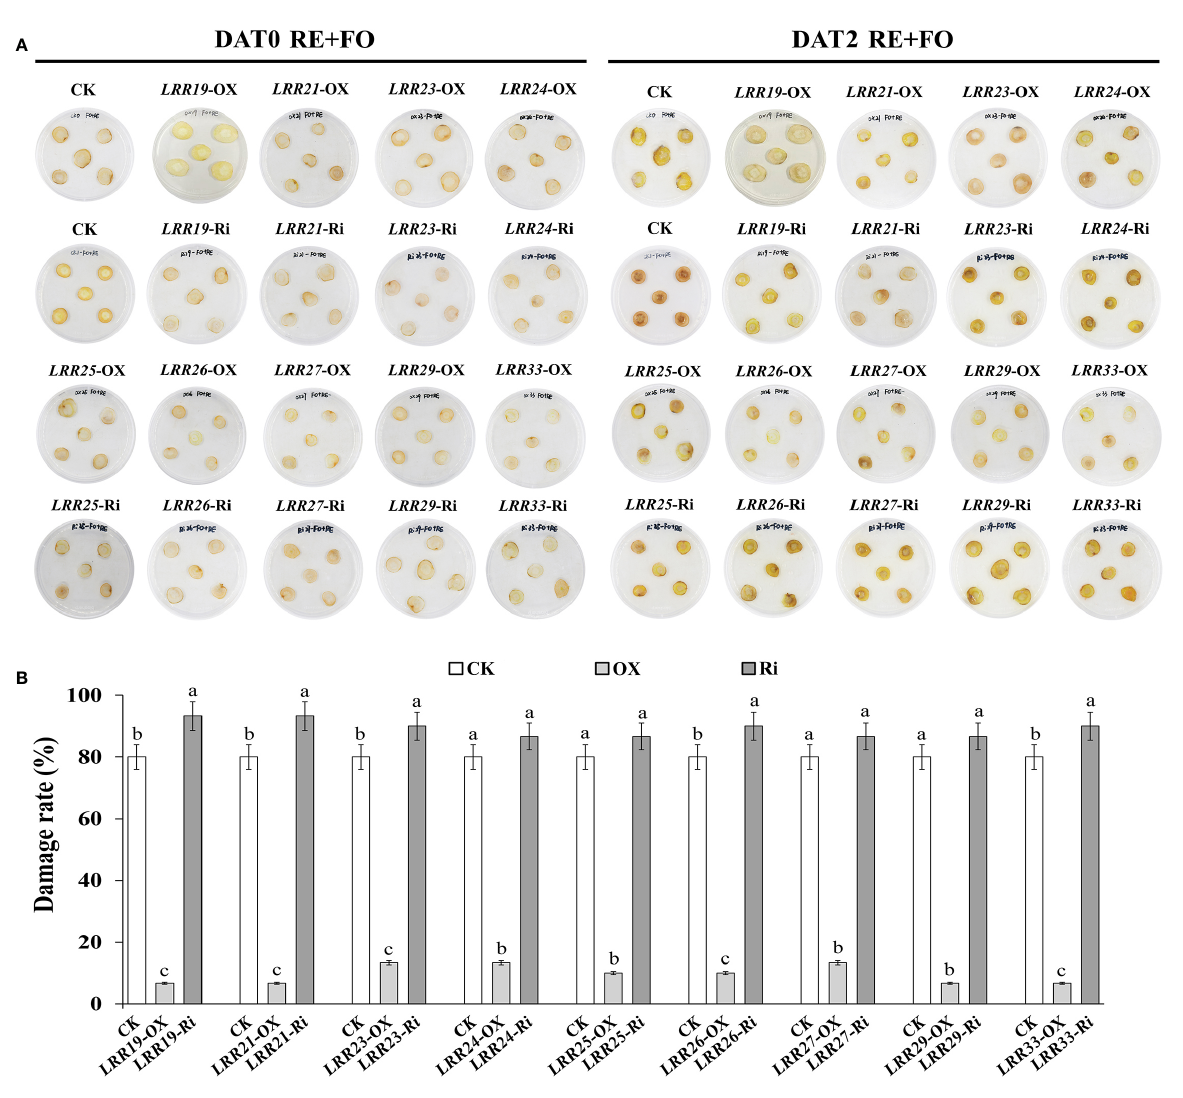
FIGURE 5 Phenotypic changes (A) and damage rate (B) of root segments with transient overexpression and interference of different RgLRRs under the treatment of comprehensive stress of root exudates and F. oxysporum . OX, Overexpression; Ri, RNA interference; CK, Empty vector as control; DAT, Days after treatment; RE+FO, the comprehensive treatment of root exudates and F. oxysporum . Different letters above bars indicated signi fi cant differences at P = 0.05 using Student-Newman-Keuls multiple